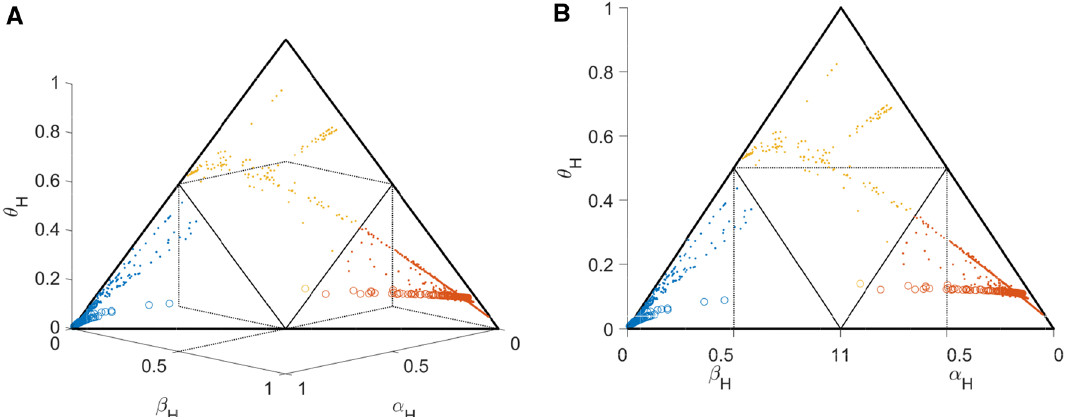
Figure 9. Decision space of hormone receptor status according to DST. ( A ) The three evidences of receptor status, belief in positive ( α H ), belief in negative ( β H ) and uncertainty ( θ H ), of all samples shown in a three dimensional plot. Colors indicate receptor assignment according to DST (positive red, negative blue, uncertain ochre). Dots: assignment via available IHC. Open circles: due to lacking IHC, assignment by ≙ ≙ imputation via DST. Decision borders according to Eq. (11) are indicated by dotted lines at α H = 0.5, β H = 0.5 ≙ and θ H = 0.5. Samples with same status assigned appear confined within the same respective tetrahedral space. Note that all points lie in one plane due to the definition ( α H + β H + θ H = 1, see SuppEq. 16) within a triangle (surrounded by heavy lines). ( B ) The triangle plane in panel (A) seen from a slightly different aspect, along a vector parallel to plane ( α H .β H ), and perpendicular to the baseline of the triangle. Decision borders are more clearly visible in this aspect. In this projection the point ( α H = 1 , β H = 1) in the foreground of panel (A) coincides with the baseline of the triangle, and so do the axes α H and β H . Note that they run in opposite directions. Hormone receptor positive samples lie exclusively in the lower right triangle, negative ones in the lower left whereas uncertain results in the kite-shaped